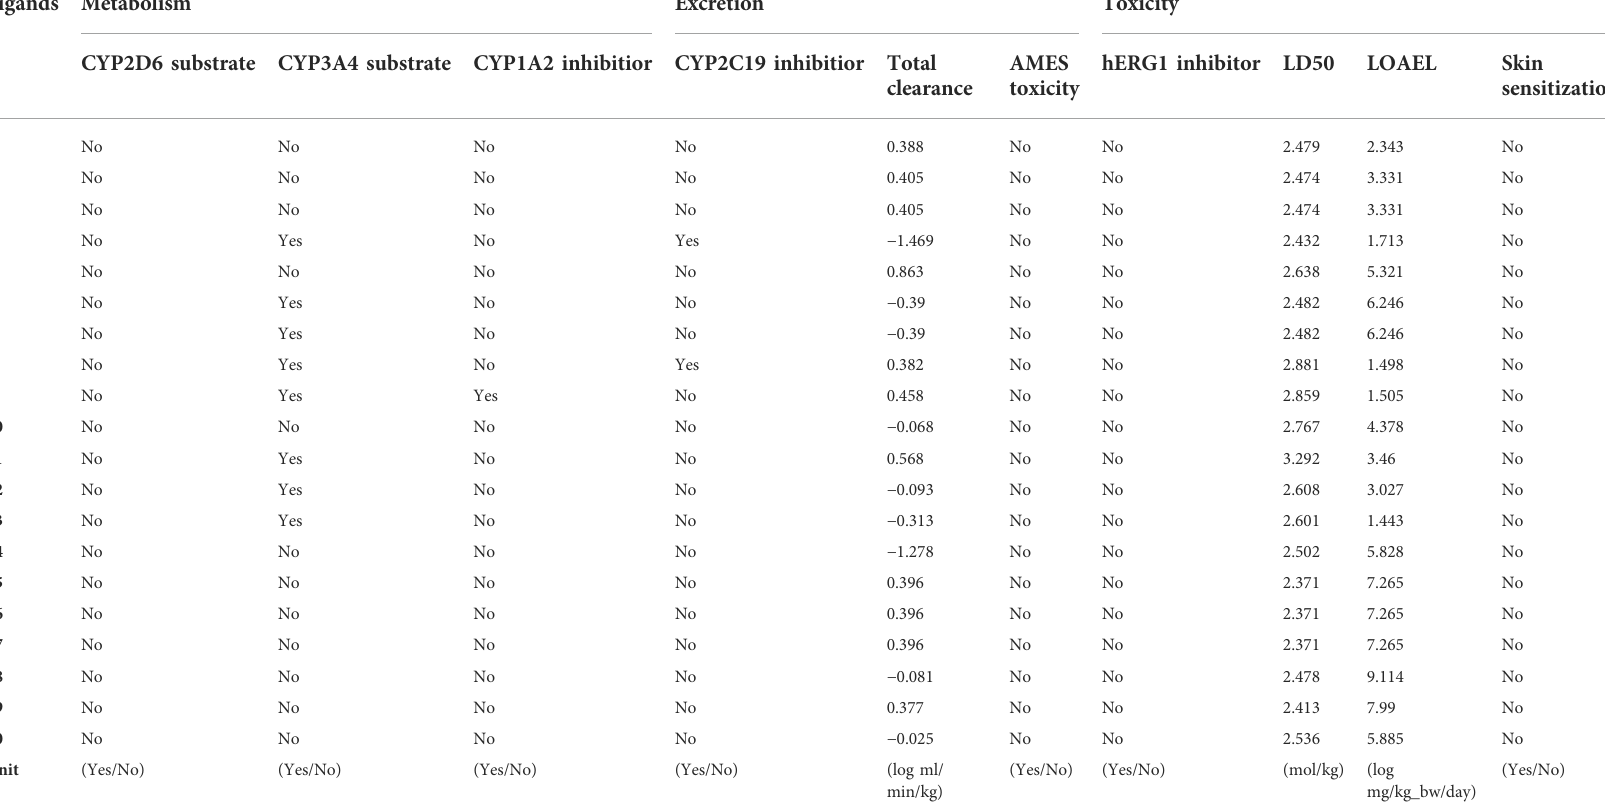
TABLE 8 Metabolism, excretion and toxicity prediction of the top 20 compounds screened by normalized assessment. Ligands